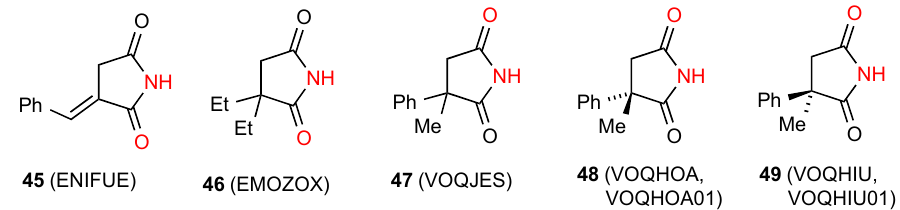
Figure 18. 3,3-Disubstituted succinimides with patterns A and B.